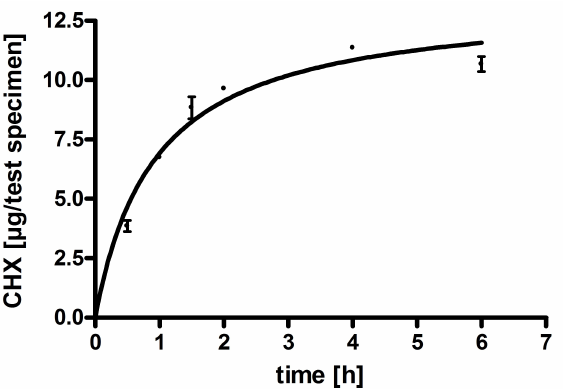
Figure A2. Adsorption of CHG to polished test specimens pre-treated with 5 M NaOH (2 h, 60 ◦ C). Kinetics of adsorption are comparable to adsorption of PHMB to NaOH pre-treated surfaces.